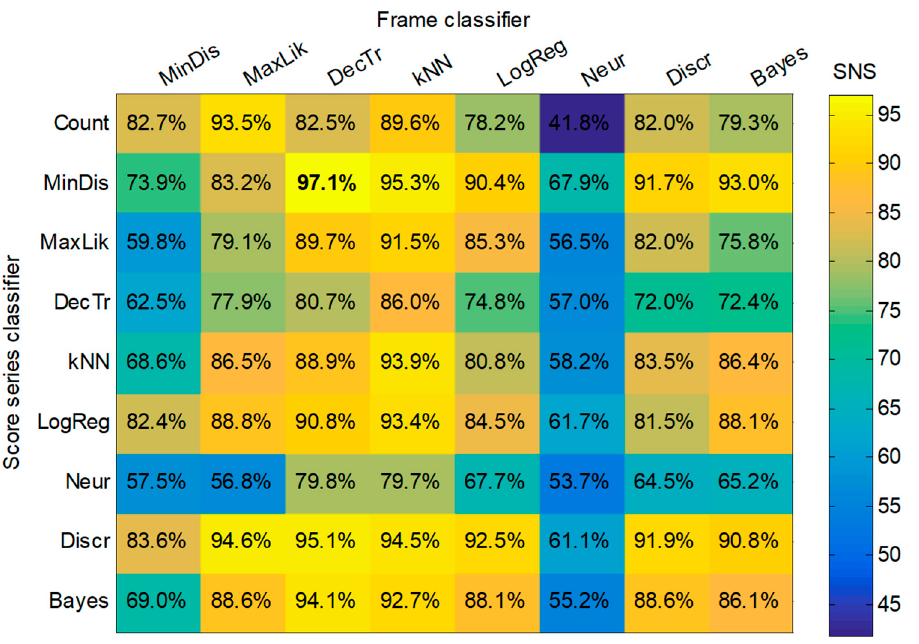
Figure 16. Improvement of the SNS obtained for each score-series classifier.